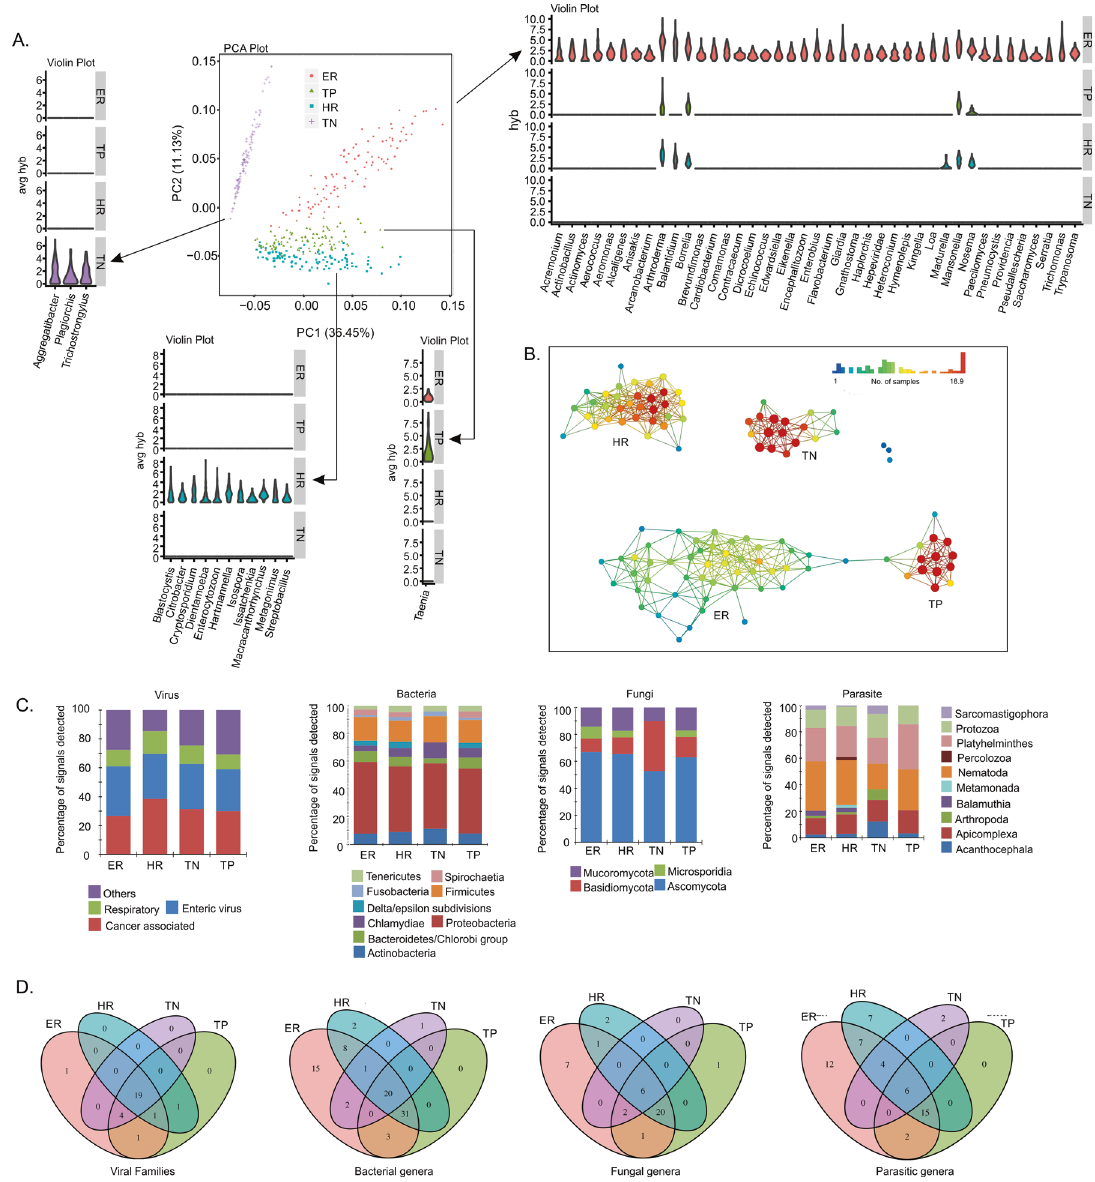
Fig. 1 Oncobiome diversity in different breast cancer subtypes. A The four types of breast cancers have distinct oncobiome compositions. PCA plot using NBClust shows that TN breast cancer oncobiome is strikingly different from the other three breast cancer subtypes studied. The unique aspects of the oncobiomes of each breast cancer subtype are represented as violin plots showing the full distribution of the data. ER + BC shows the most diversity in oncobiome. B Using topological data analysis, we further show the similarity in the oncobiomes of triple positive and ER positive BCs, while both Her2 + and triple-negative breast cancer have oncobiome characteristics very different from other BCs. C Bar graphs showing different types and phyla of oncobiome in the four breast cancer subtypes. D Venn diagrams show the viral and microbial signatures that are shared and unique to the four breast cancer others. This was primarily due to (1) the detection of fewer microbial agents in the TN samples (the least diverse); (2) a signi fi cantly higher detection of Aggregatibacter (Fig. 1A, violin plots); and (3) the detection of Plagiorchis and Trichostrongylus Figure 1B used topological data analysis that suggested greater (Fig. 1A, violin plots). These factors made a distinct cluster for the similarity between the oncobiomes of TP and ER subtypes, while TN BC samples in the PCA plot. Conversely, ER + BC samples HR and TN cancers had oncobiome characteristics very different showed the most robust oncobiome, with a greater number of from the other BCs. Among the receptor negative BCs, HR differed bacterial (mostly Proteobacteria), fungal, viral, and parasitic from TN by having greater signals for signatures of Togaviridae signatures with higher unique signals (Fig. 1A, violin plot). HR and Astroviridae , and signatures of Ehrlichia , Wolbachia , Bartonella , and TP BC subtypes showed intermediate oncobiome densities Legionella , and Campylobacter , whereas the TNs had higher signals with fewer bacterial ( Citrobacter , Streptobacillus ), fungal ( Enterocy- for signatures of Alloherpesviridae , Arenaviridae , and Nodaviridae tozoon , Issatchenkia ), and parasitic ( Blastocystis , Cryptosporidium ,